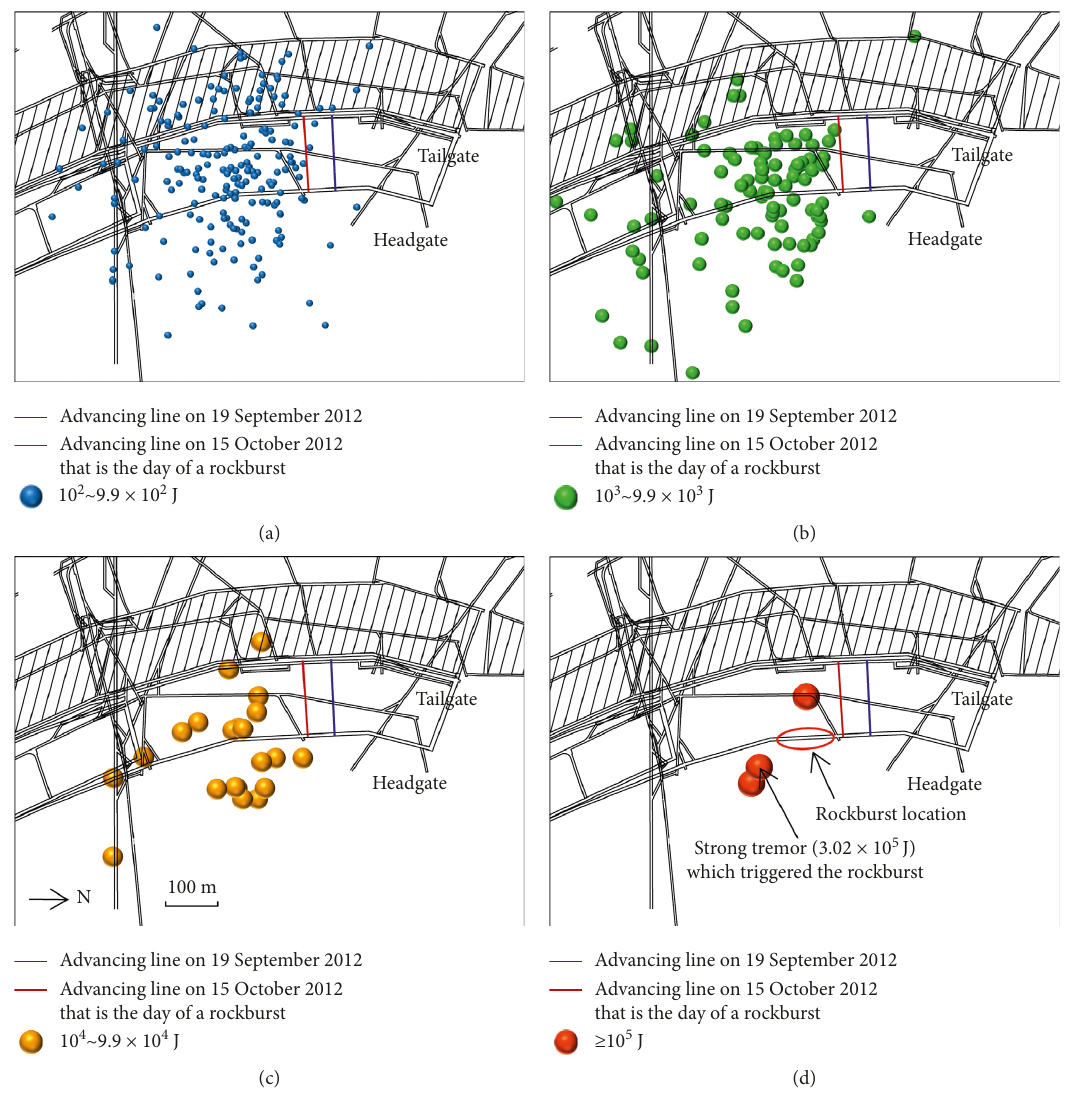
Figure 2: Tremors with different energies occurring during mining from 19 September to 15 October 2012.